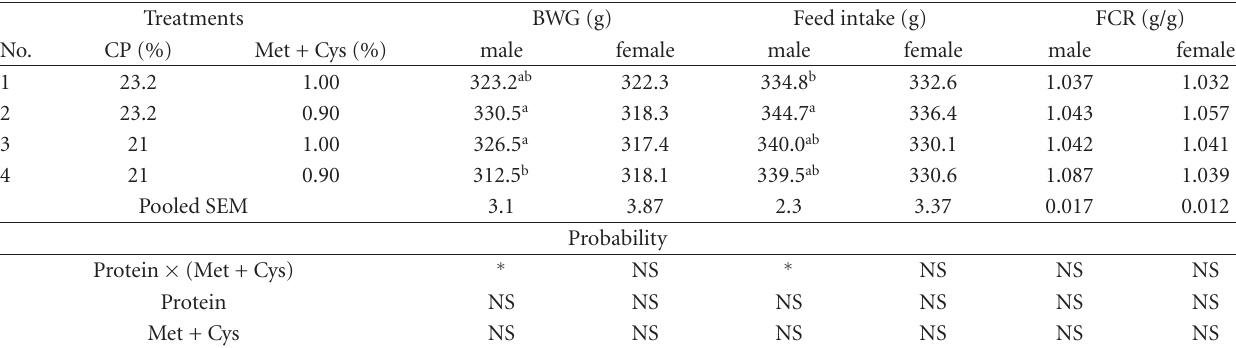
Table 6: E ff ect of feeding diets containing two levels of crude protein (CP) and methionine + cystine (Met + Cys) on body weight gain, feed intake and feed conversion ratio of male or female broiler chicks at 10d (Experiment